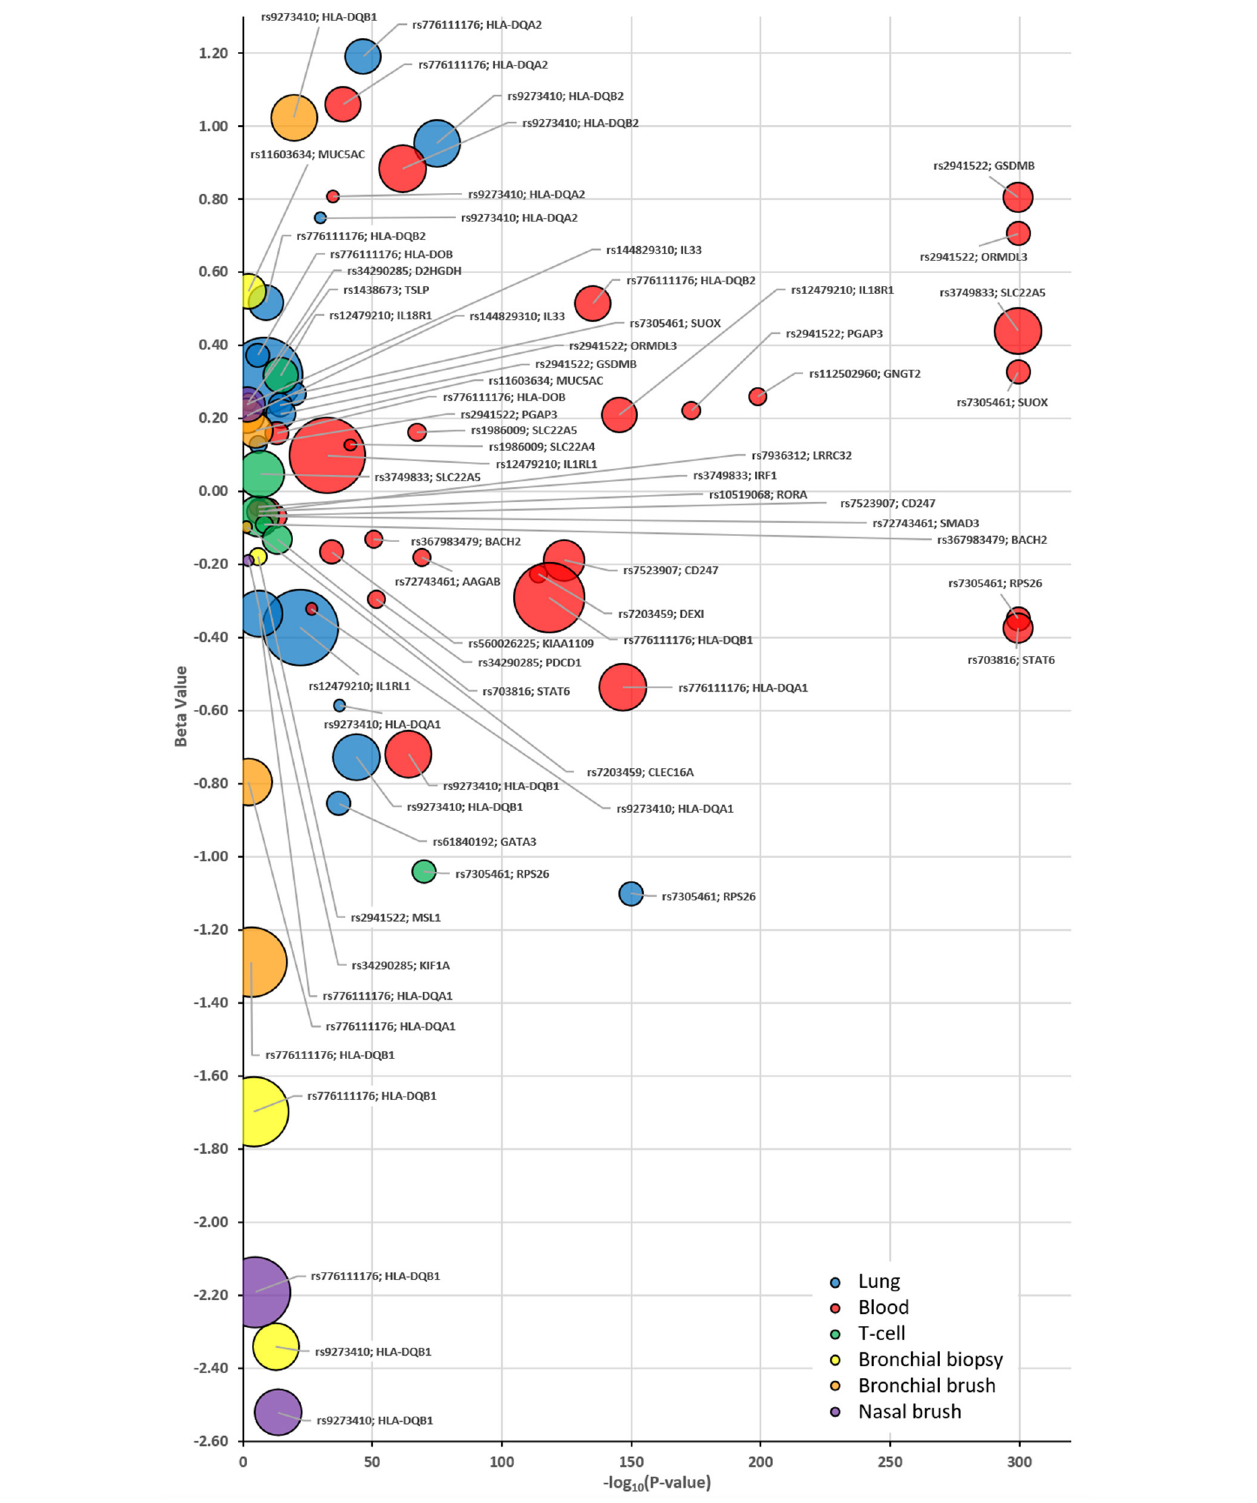
FIGURE 3 | Bubble plots identifying the eQTL patterns for each selected SNP:Gene pairing as identified in Table 3 and tissue specific eQTLs. Plot identifies each eQTL P -value (x-axis) and B -value (y-axis) stratified based on the asthma risk allele for each identified compartment as denoted by the corresponding color; Blue = Lung, Red = Whole Blood, Green = T-cells, Yellow = U-BIOPRED Bronchial Biopsy, Orange = U-BIOPRED Bronchial Brush and Purple—U-BIOPRED Nasal Brush. The size of the bubble indicates the generated score in Table 3 . EQTLs listed are those that achieved a P -value of P < 0.05 in one of the interrogated datasets.